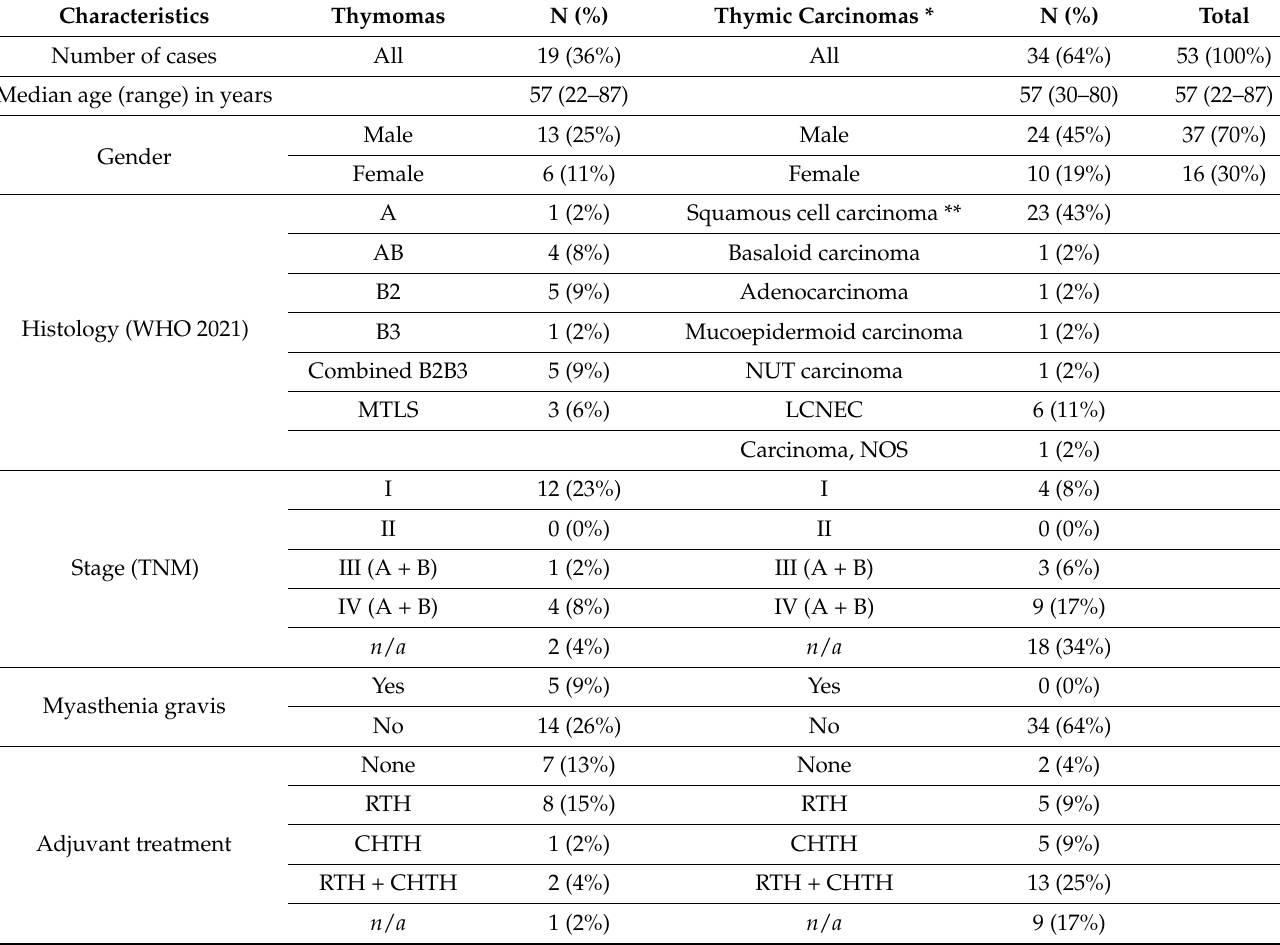
Table 1. Clinicopathological characteristics of 53 patients with thymic epithelial